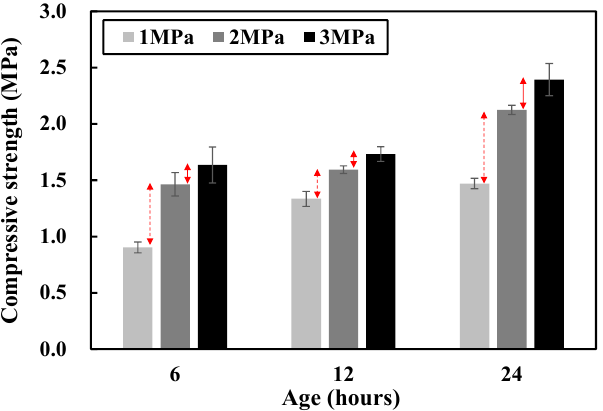
Figure 3. Compressive strength deviation in different compressive load and ages.